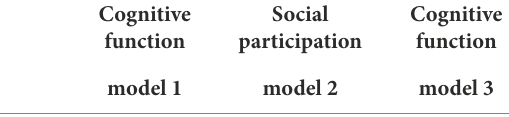
TABLE 4 Mediating effect stepwise regression results, OR (95%